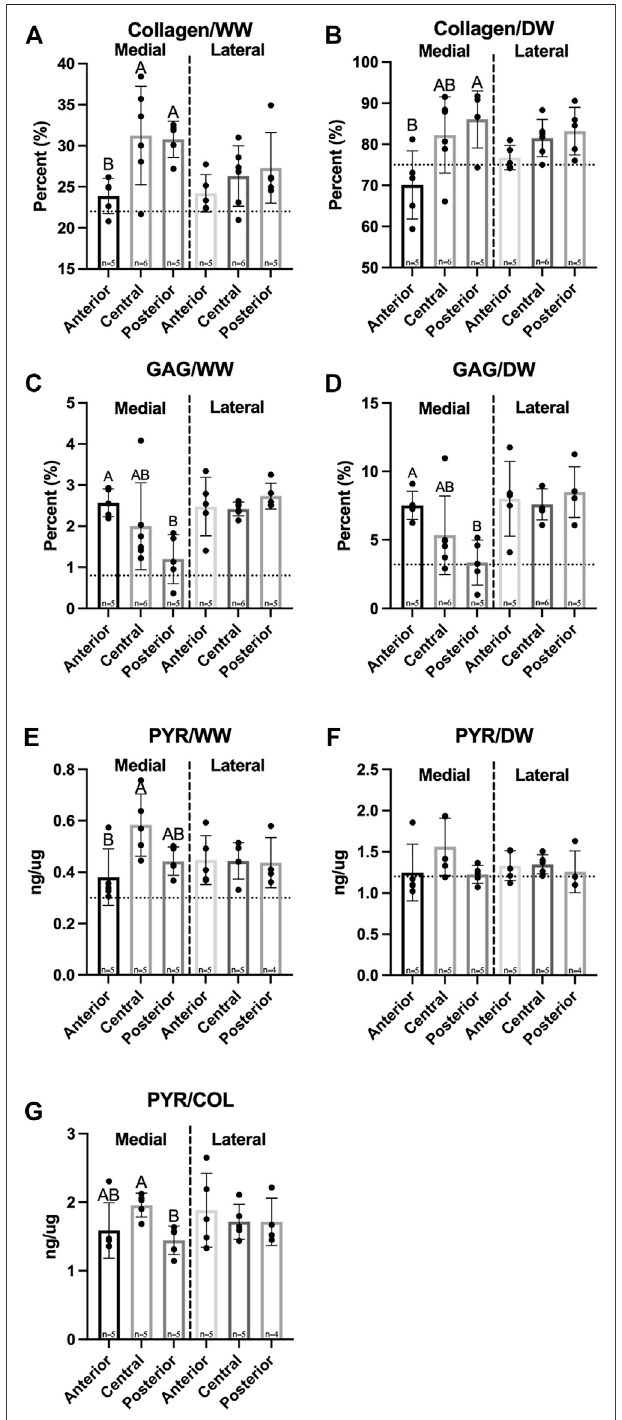
FIGURE 6 | Biochemical properties of Yucatan minipig menisci. (A – F) Collagen, GAG, and pyridinoline crosslink content are shown normalized to wet and dry weights, respectively, in addition to (G) crosslinks normalized to collagencontent.Student ’ s t -testshows signi fi cantdifferencesbetween medial and lateral menisci in GAG content. One-factor ANOVA showed pyridinoline crosslinks normalized to collagen content was signi fi cantly higher in the central region of the medial meniscus compared to its posterior region; ( Continued )